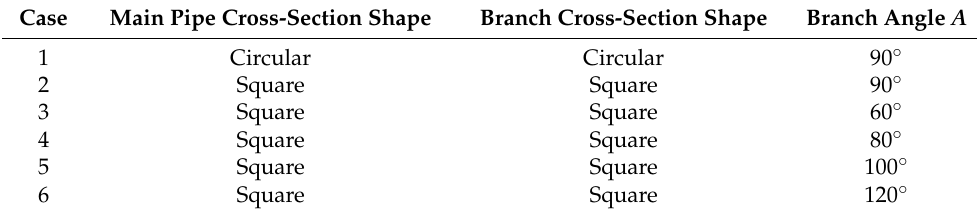
Table 1. Configuration of the